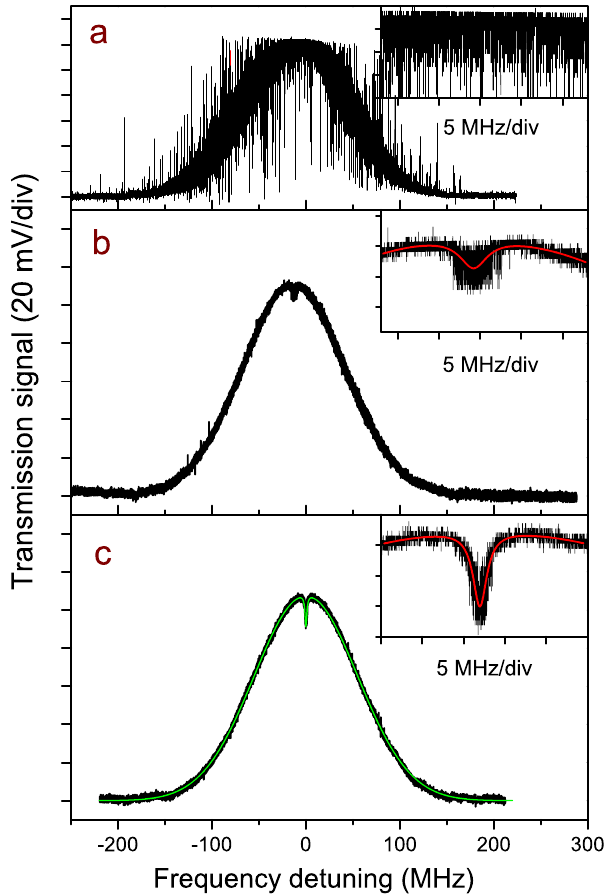
Figure 7. Optical transmission signal through the spectroscopic cell with the laser scanning of the CO 2 transition. The three cases corresponding to the different traces are: free-running laser operated with the commercial driver ( a ); laser operated with the home-made driver in free-running ( b ) and locking ( c ) conditions. All three graphs have the same horizontal scale, representing the detuning from the center frequency of the transition. In each inset, a zoom of the top line profile is shown, over the same horizontal and vertical scales, with the red curves showing the Lorentzian fit of the dip ( b , c ). The thin green trace superimposed on the data in ( c ) is a simulation of the sub-Doppler feature based on the HITRAN data, as described in the